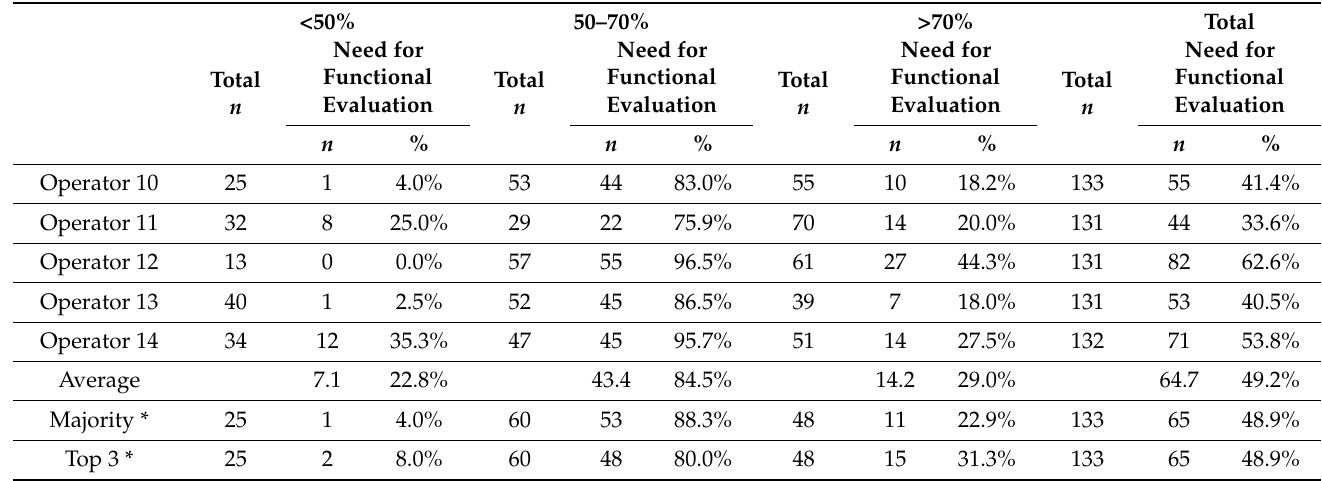
* classification based on overall agreement for the degree of severity. Table A5. The number of fractional-flow rate (FFR) measurements in the two hybrid approaches and the difference between these concerning the number of FFR.